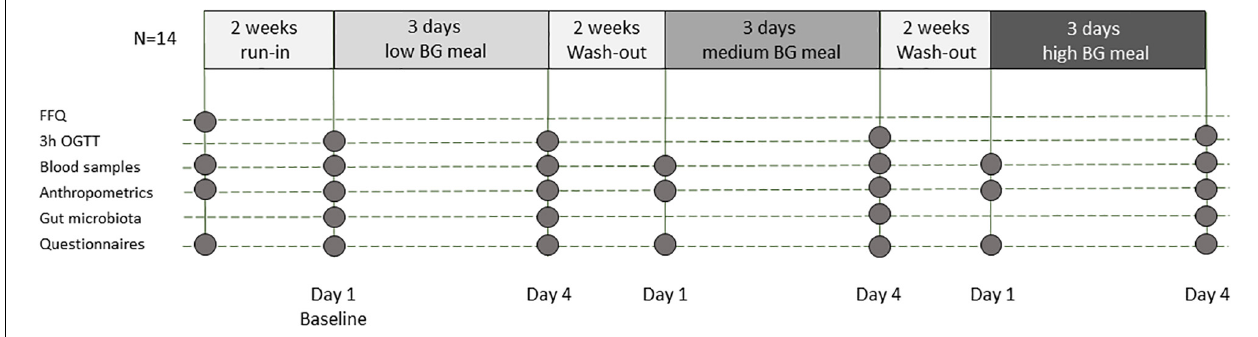
FIGURE 1 | Study design. BG: beta-glucan, FFQ: food frequency questionnaire; h: hours; N: number of participants; OGTT: oral glucose tolerance test.